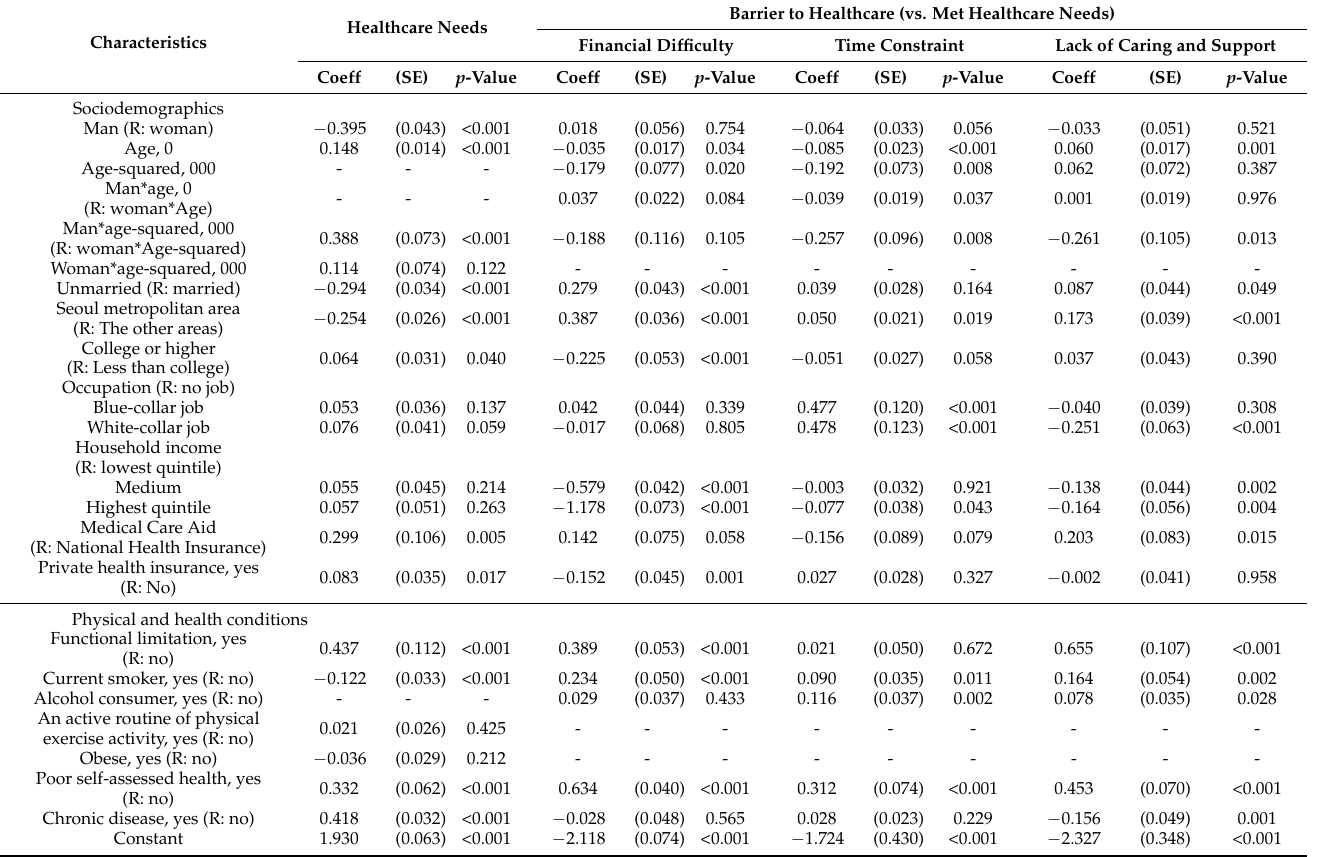
Table 2. The associations between people’s characteristics and the people’s experience of healthcare needs, and between people’s characteristics and the people’s experience of a specific type of barrier that leads to unmet healthcare needs among the people who needed healthcare